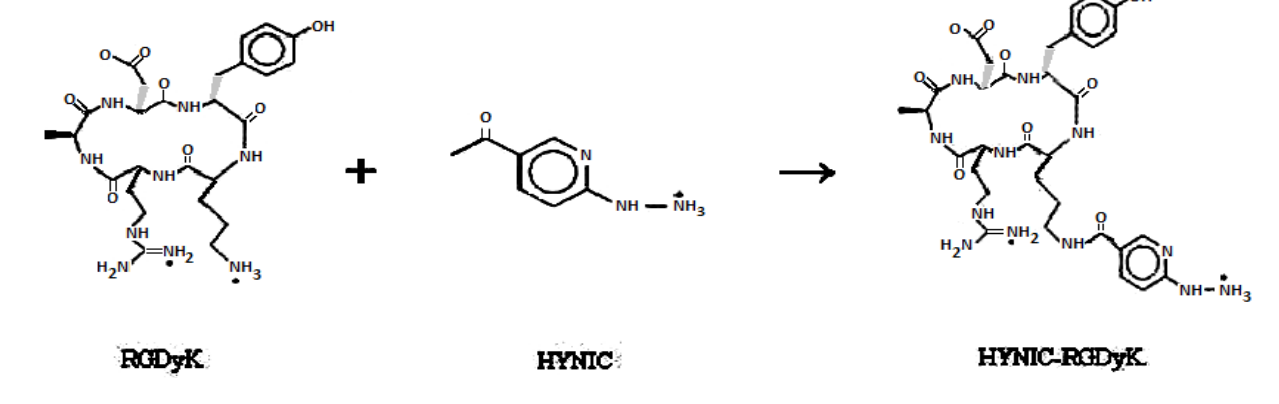
FIGURE 1 – Scheme of HYNIC-RGDyK